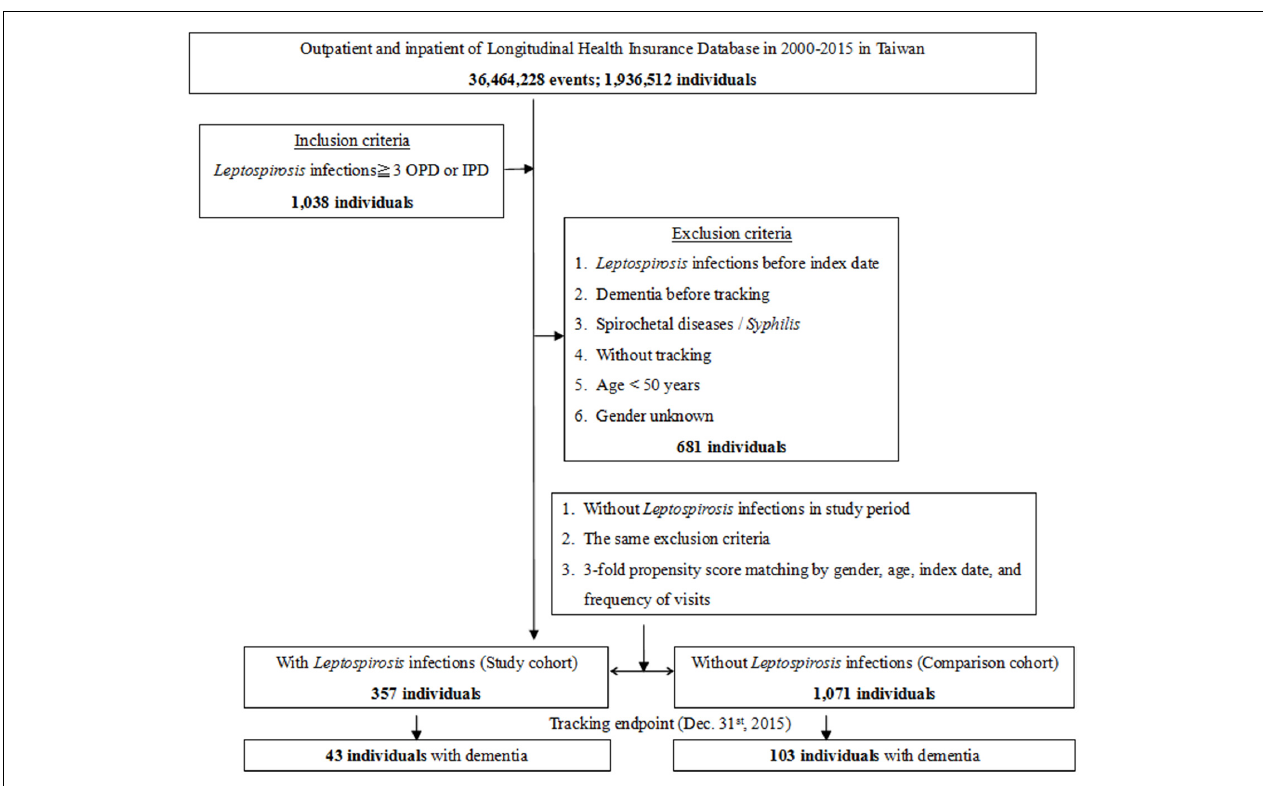
FIGURE 1 | The flowchart of study sample